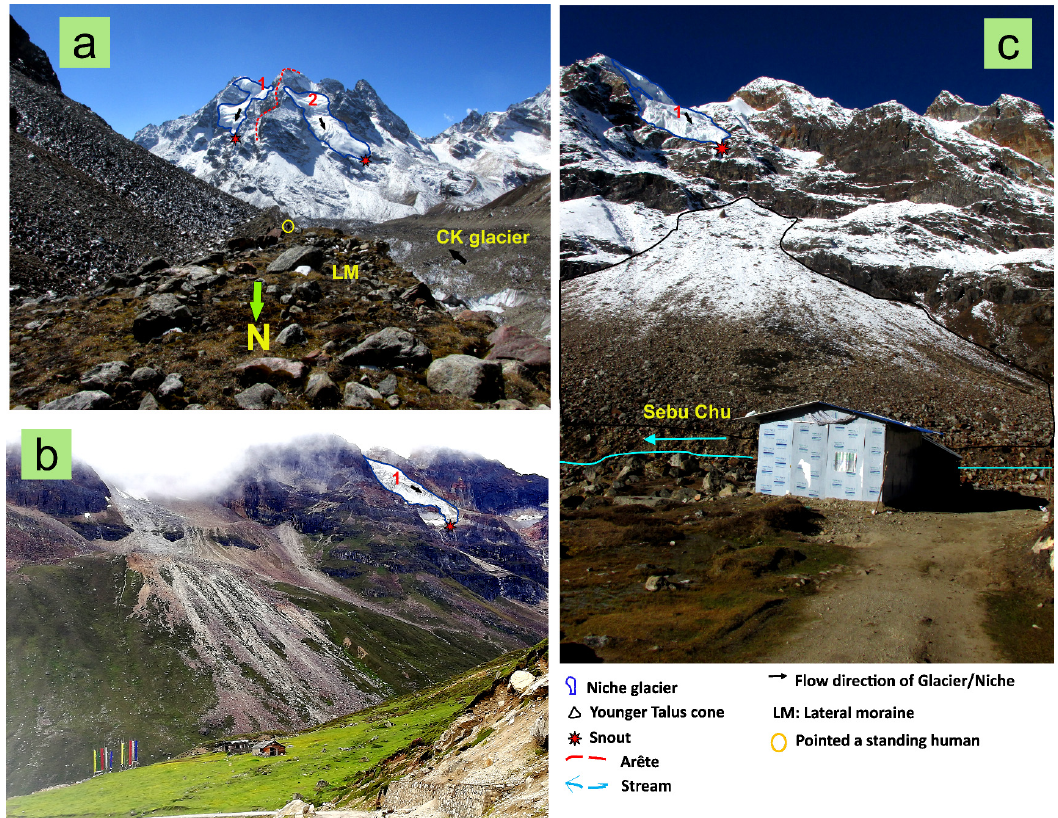
Figure 7. The niche glaciers developed on the northern slope, ( a ) field photograph (November 2015) of two niche glaciers developed on a single mountain slope separated by an Arête (red dashed line); ( b ) field photograph (November 2018) of the side face of niche-1 glacier; ( c ) field photograph (November 2016) of a fresh talus cone spread below the snout of the niche-1 glacier and the toe being truncated by the stream (Sebu Chu) (blue dashed